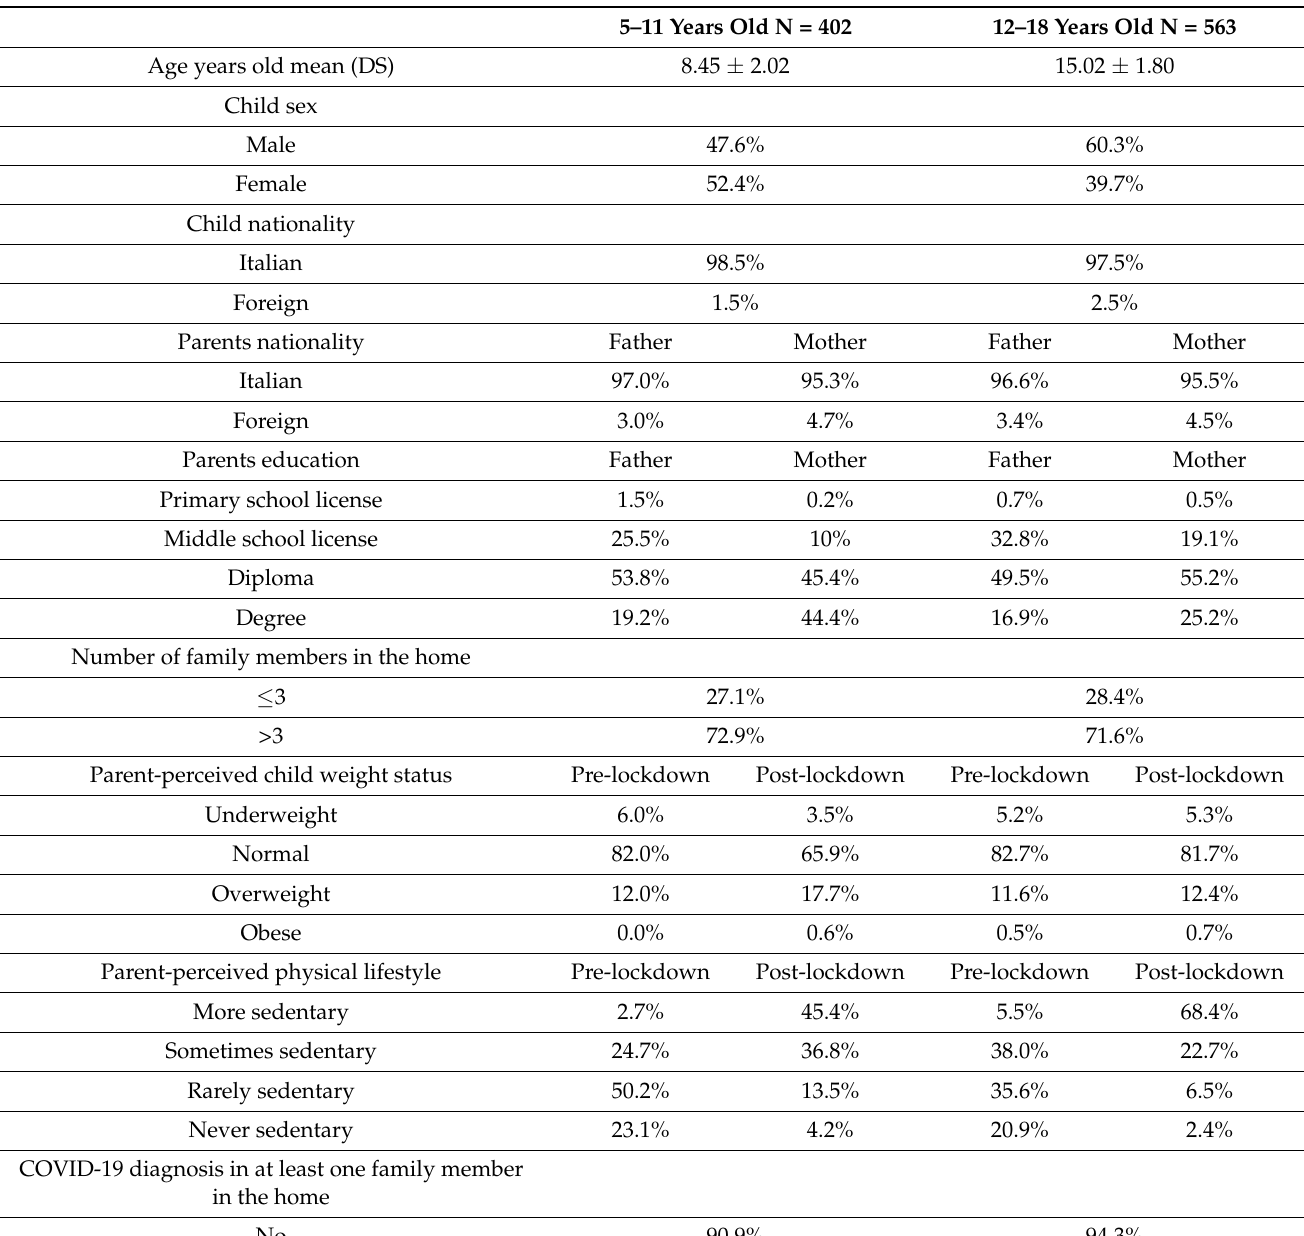
Table 1. Demographics and COVID-19 Related